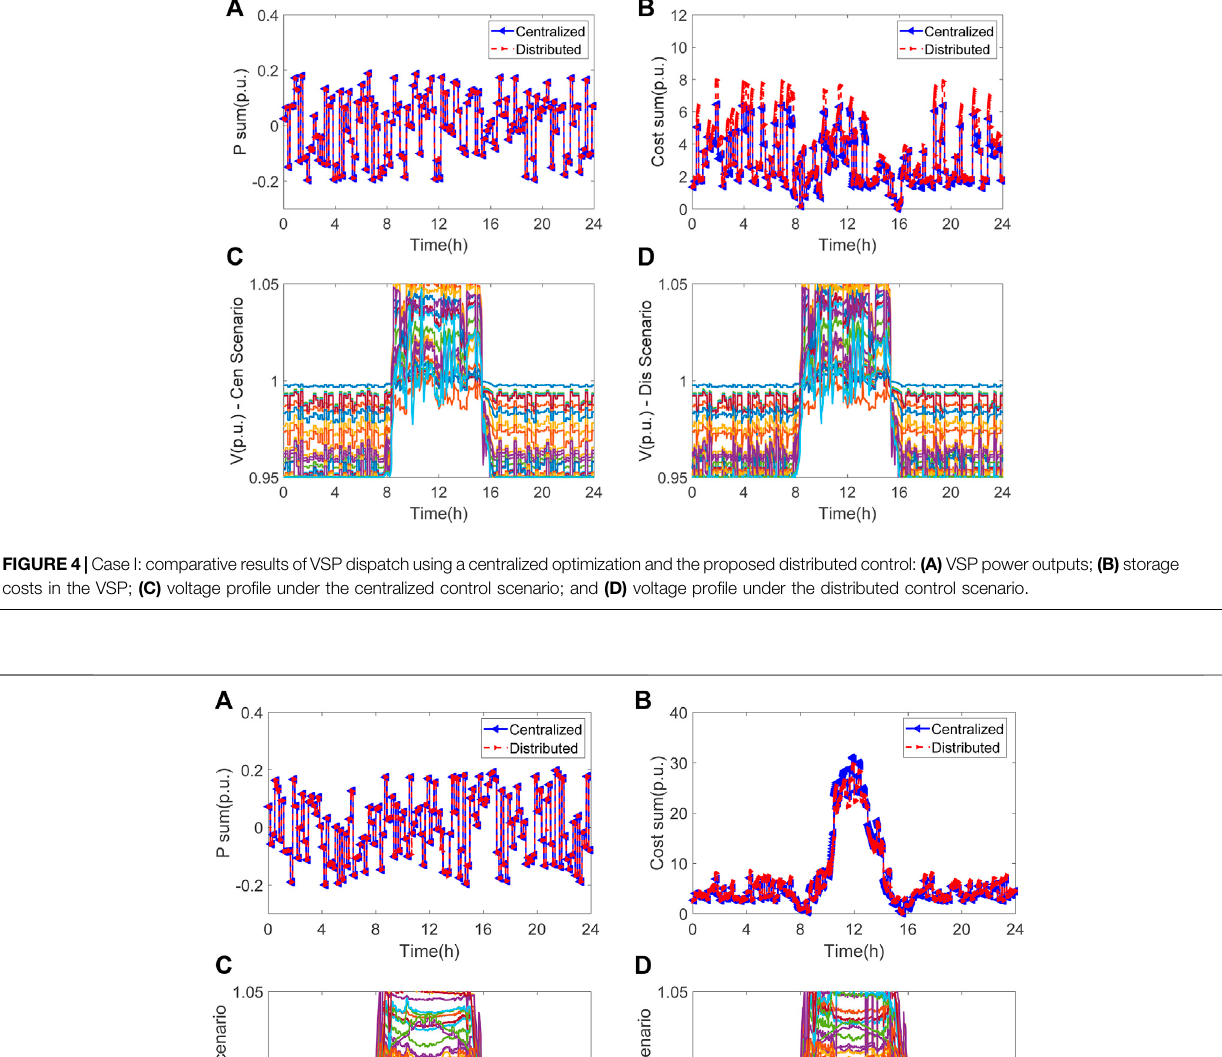
Frontiers in Energy Research |